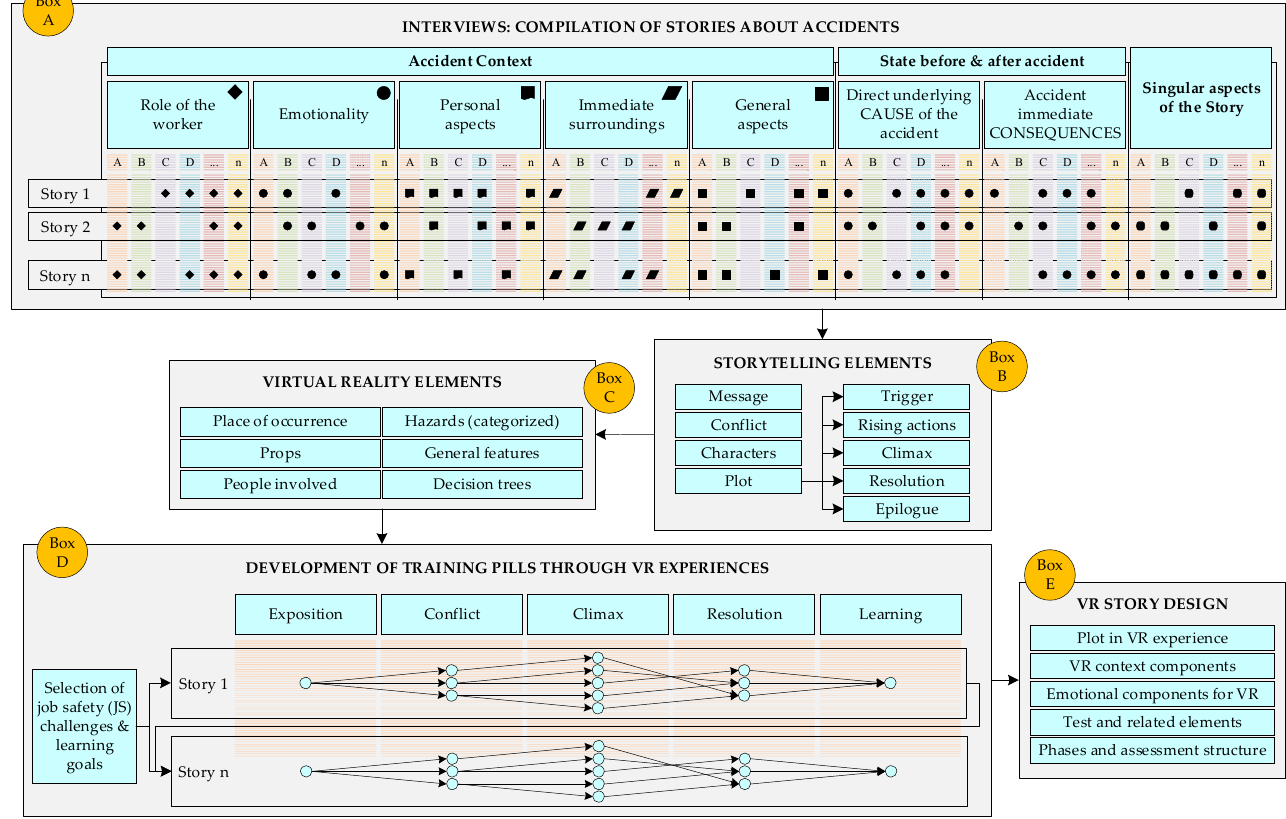
Figure 19. Map for developing narratives for VR training experiences for OHS in